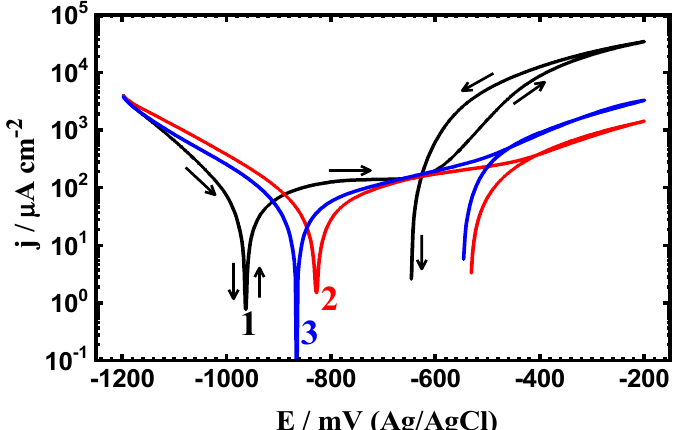
Figure 6. CPP measurements for (1) PS, (2) PSC1, and (3) PSC2 in 4% NaCl solution after 24 h of exposure.